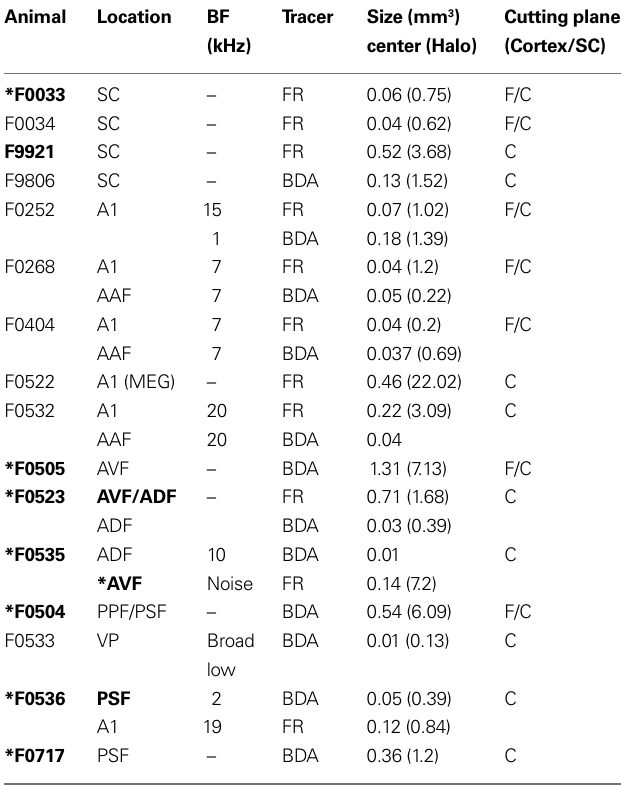
Table 1 | Tracer injections in each animal used in this